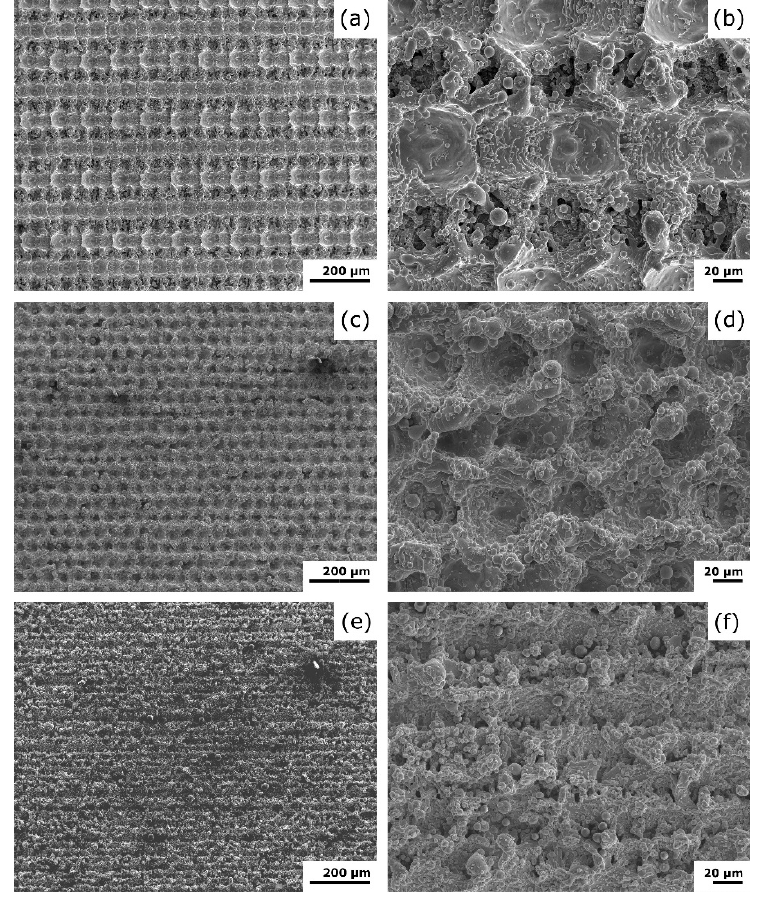
Figure 1. SEM micrographs of the laser-textured surfaces with different scanning line separations: ( a , b ) ∆ x = ∆ y = 100 μ m, ( c , d ) ∆ x = ∆ y = 50 μ m, ( e , f ) ∆ x = ∆ y = 25 μ m.